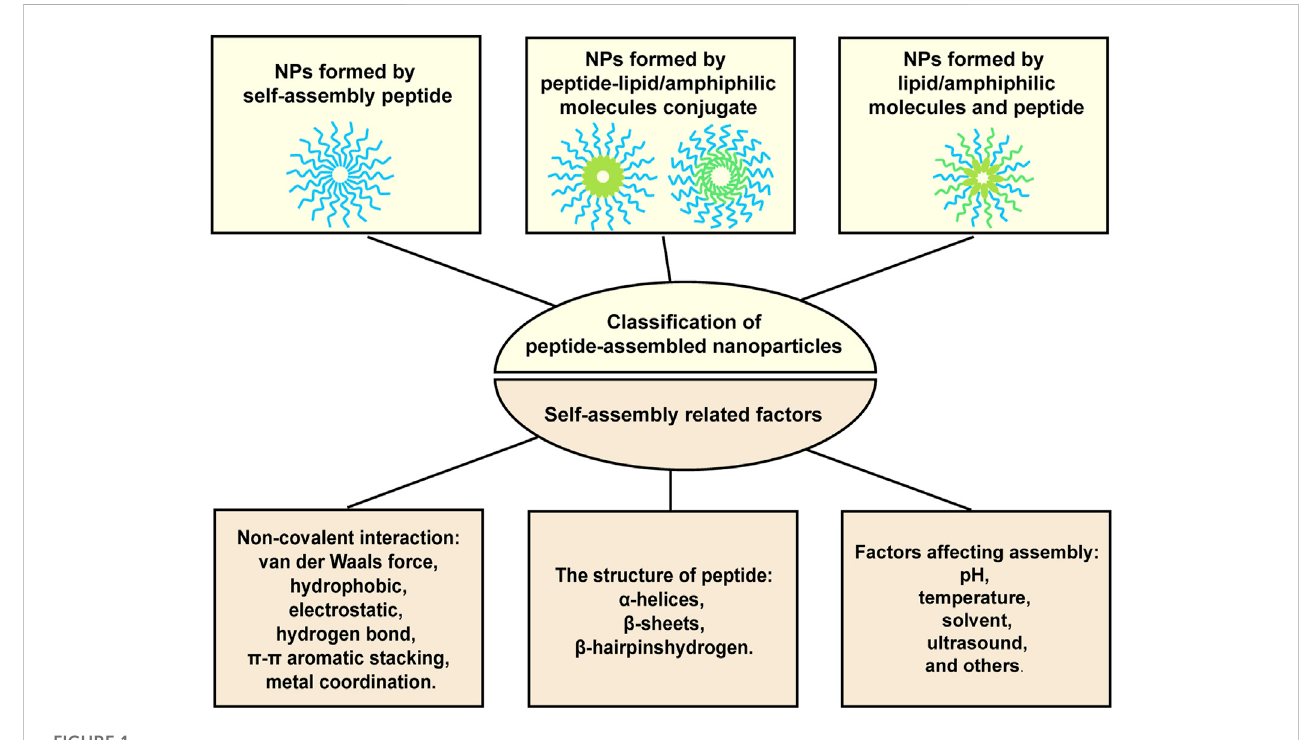
FIGURE 1 Illustration of the formation strategies for peptide-based